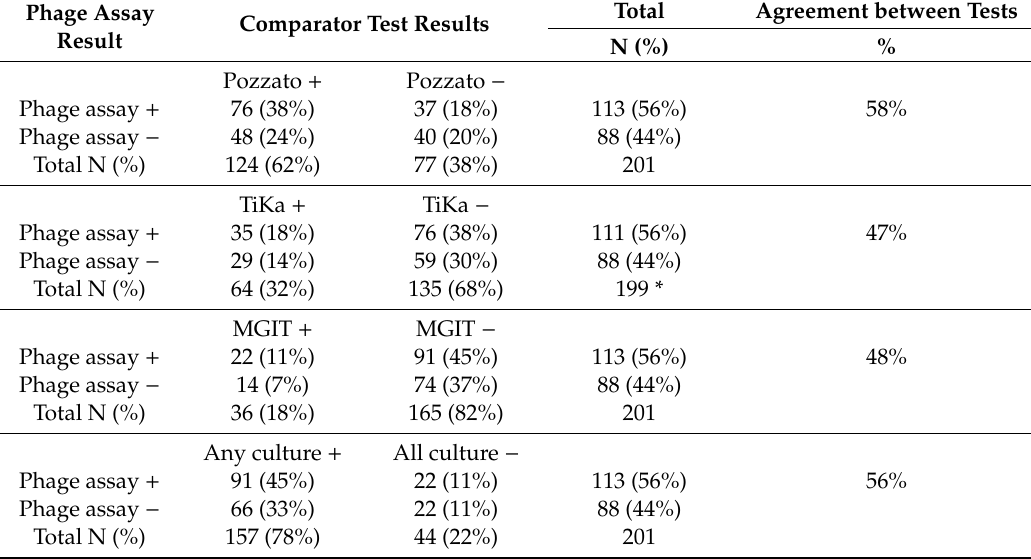
Table 6. Agreement analysis between Phage assay and culture results ( n =